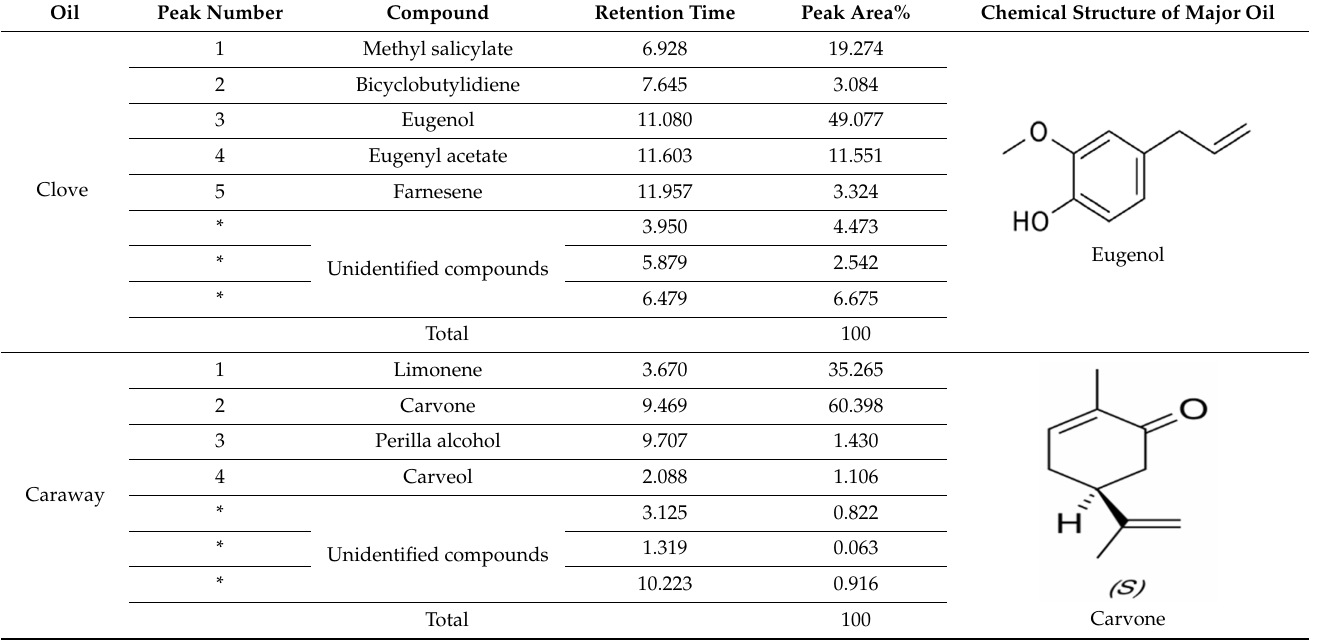
Table 1. Chemical composition of essential oils from clove buds and caraway seeds.